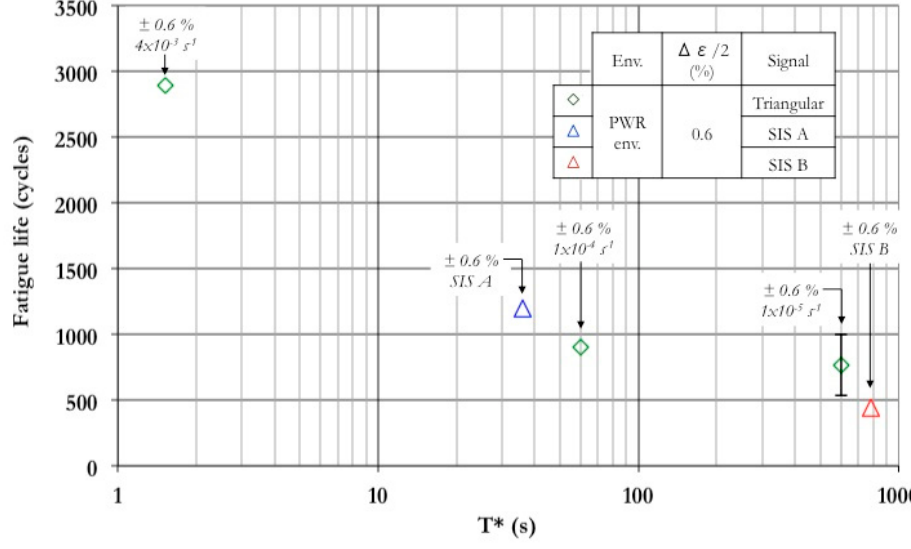
Figure 17. Fatigue lives in the PWR environment as a function of the T * parameter.